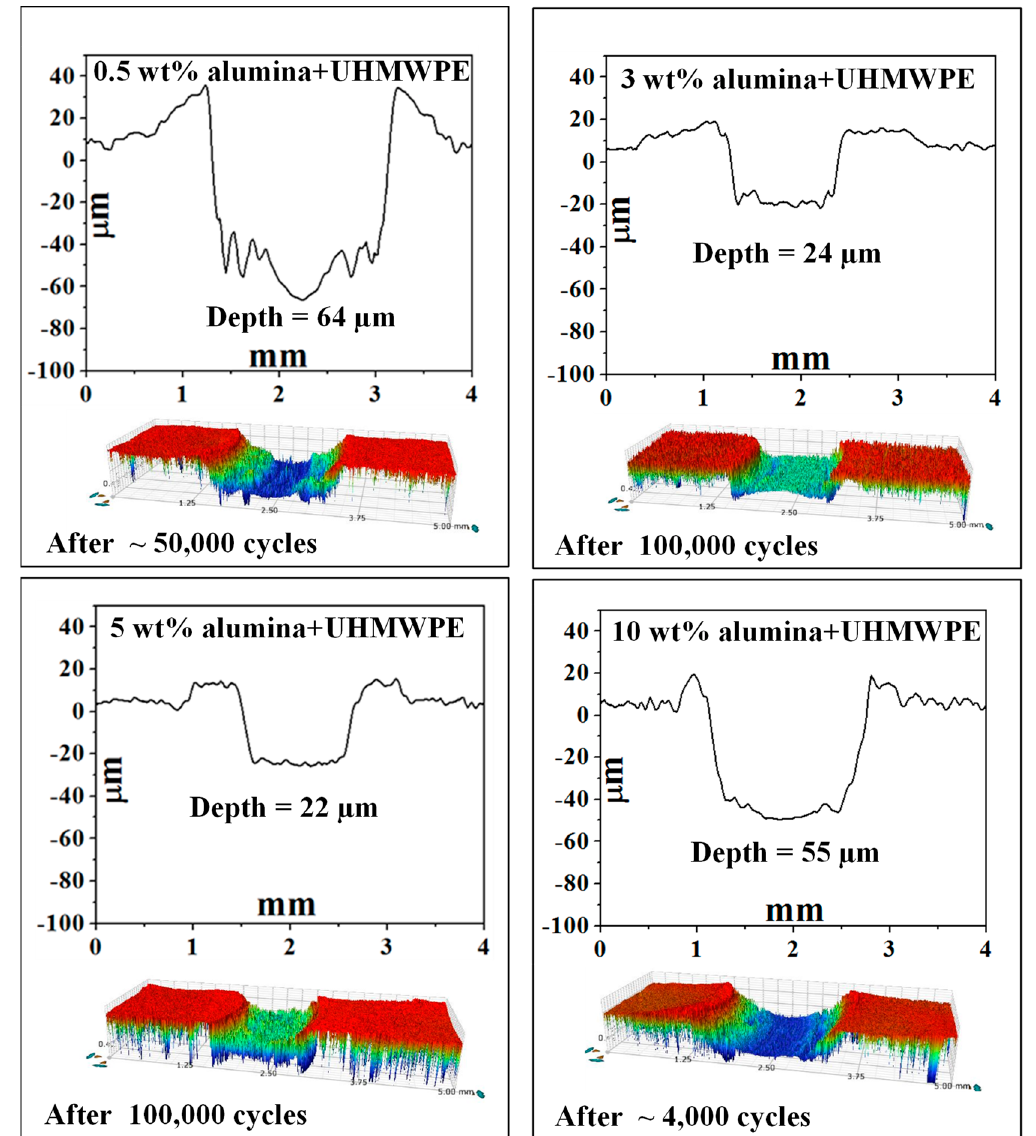
Figure 9. 2D and 3D optical profiles of the wear track for all the nanocomposite coatings after a sliding wear test at a normal load of 12 N and at a sliding speed of 0.1 m/s.